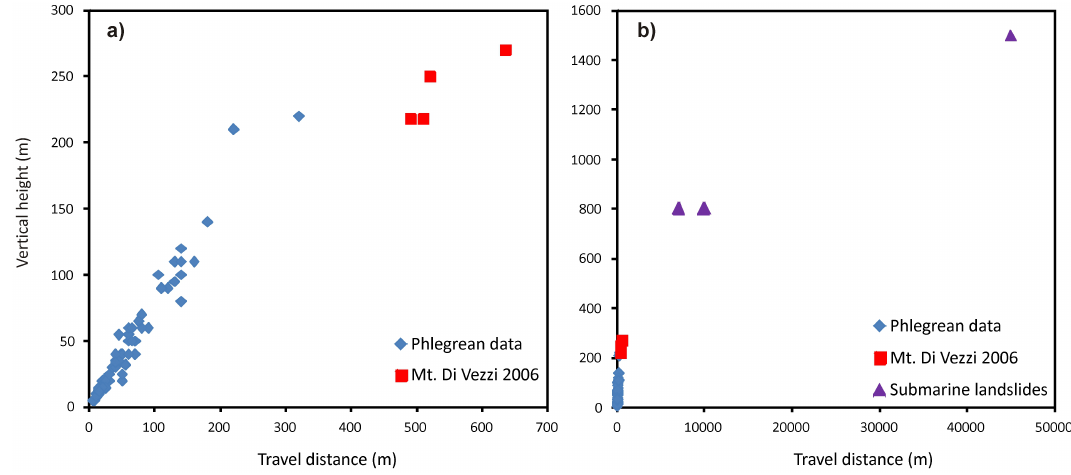
Fig. 13. Relationships between vertical height and travel distance for the flow-like movements that occurred in the Phlegrean Fields: (a) ter- restrial events; (b) terrestrial and submarine events.